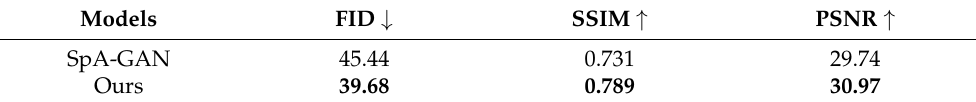
Table 4. Numerical comparison of cloud removal on the RICE2 dataset.